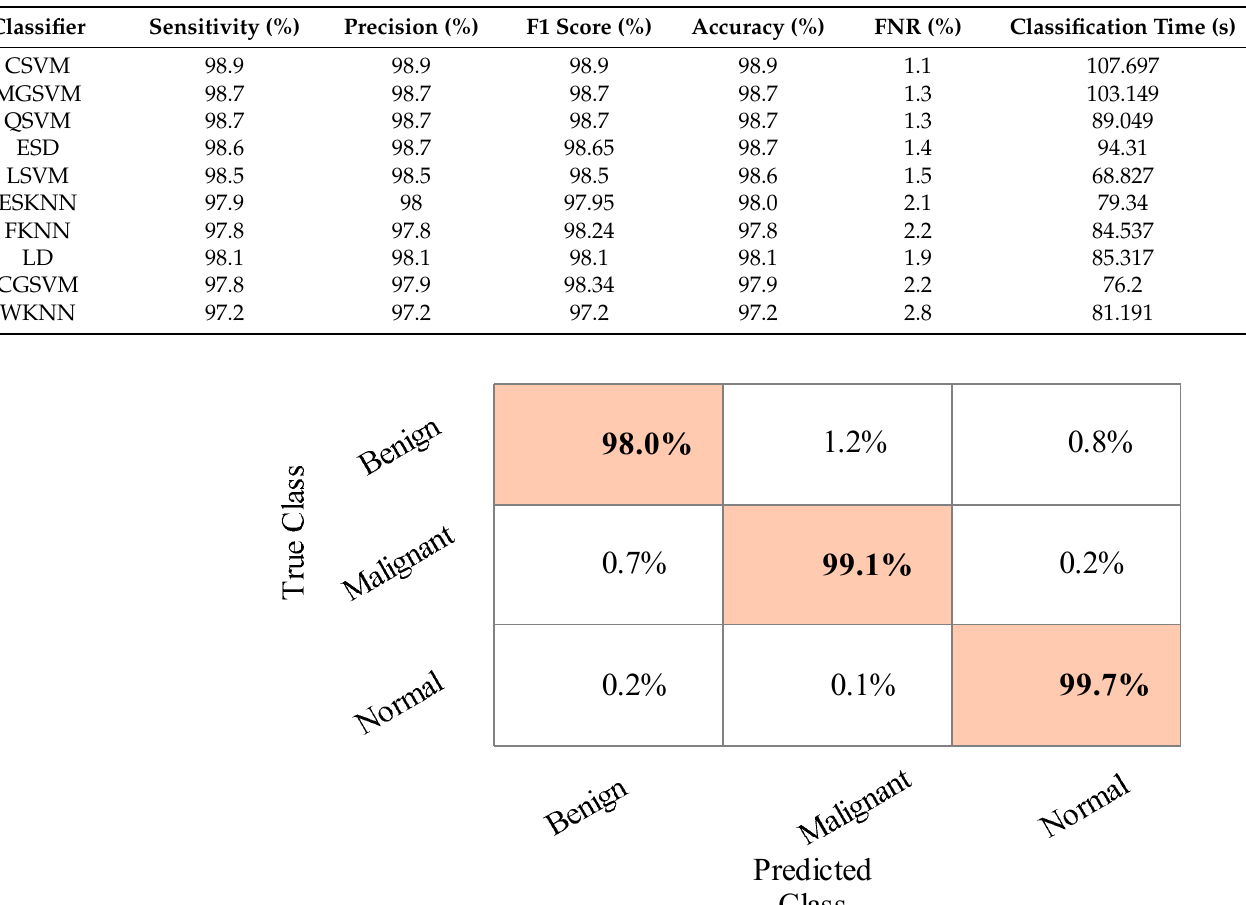
Table 4. Classification results of DarkNet53 using ultrasound images, where the training/testing ratio is 60:40.